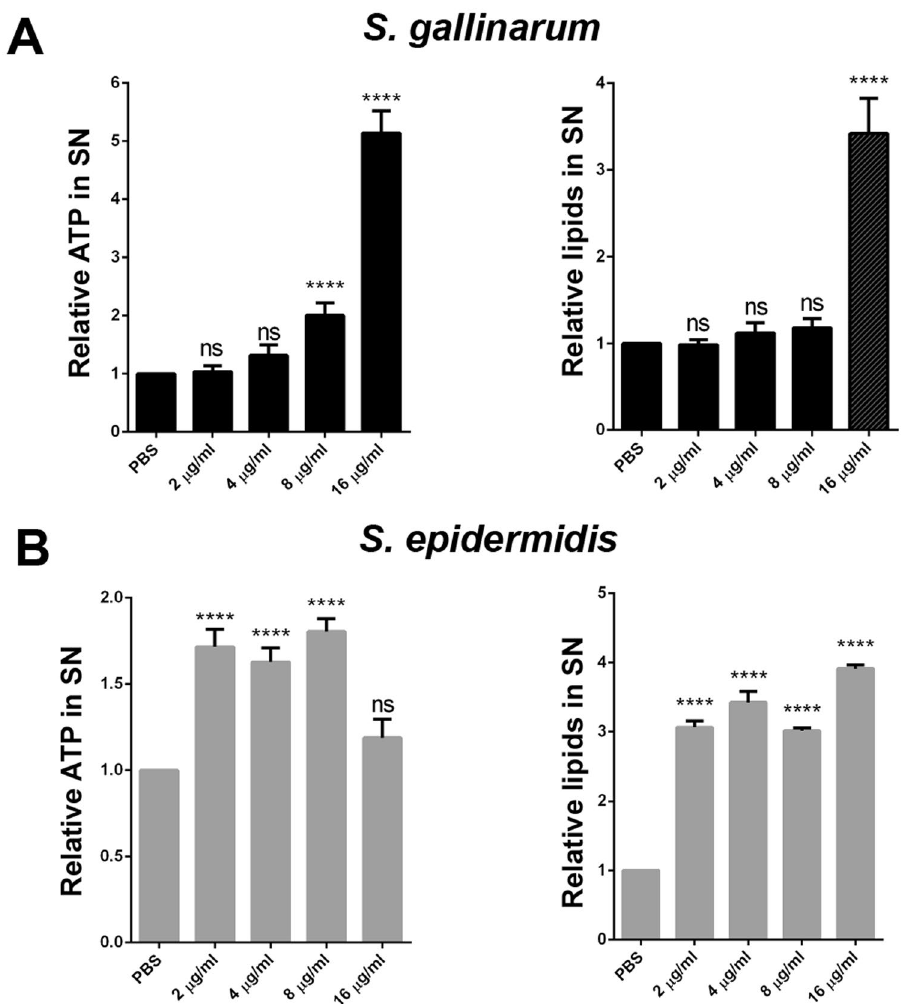
Figure 6. Gdm induced release of ATP and lipids. ATP and lipids were analyzed in the culture supernatants of untreated (PBS) and Gdm treated samples (2, 4, 8, 16 μ g/ml) in S. gallinarum ( A ) and S. epidermidis ( B ). Amounts of ATP and lipids in treated samples were normalized to the untreated control. Representative data from at least two independent experiments are shown, each data point is the mean value ± SD * p < 0.05, ** p < 0.01, *** p < 0.001 **** p < 0.0001 ordinary-one-way-ANOVA with Bonferroni